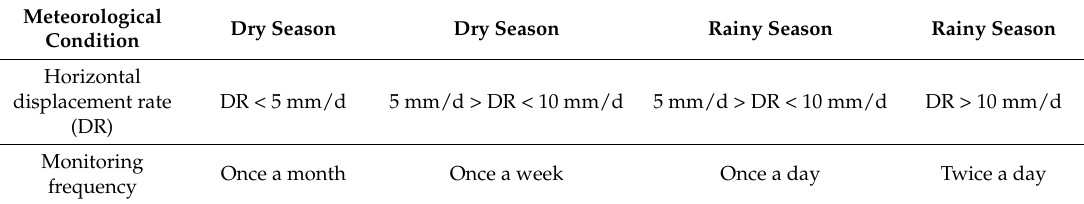
Figure 6. Surface horizontal displacement rates for gauges W6, W7 and W11. Table 1. Horizontal displacement rate and monitoring frequency during dry and rainy seasons.